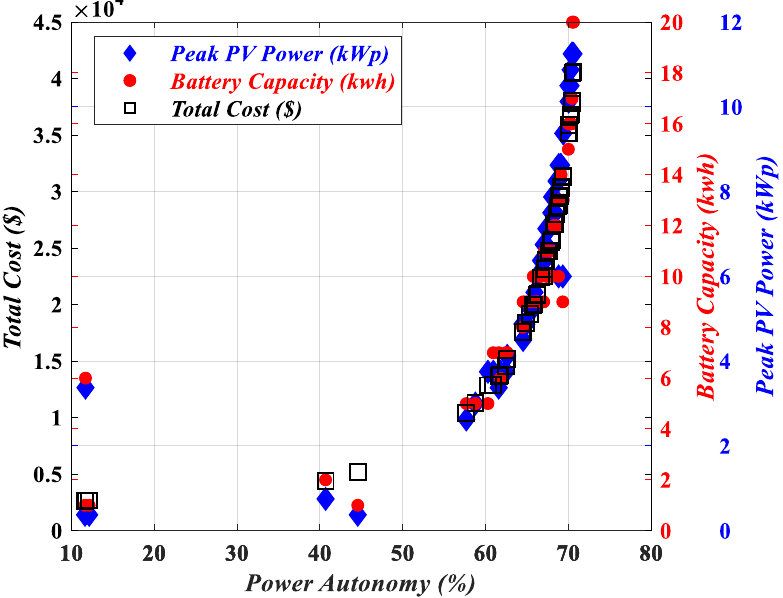
Figure 7. Total cost and power autonomy factor for a variety of PV panel installation areas and battery capacity values for Aalborg (commercial area).